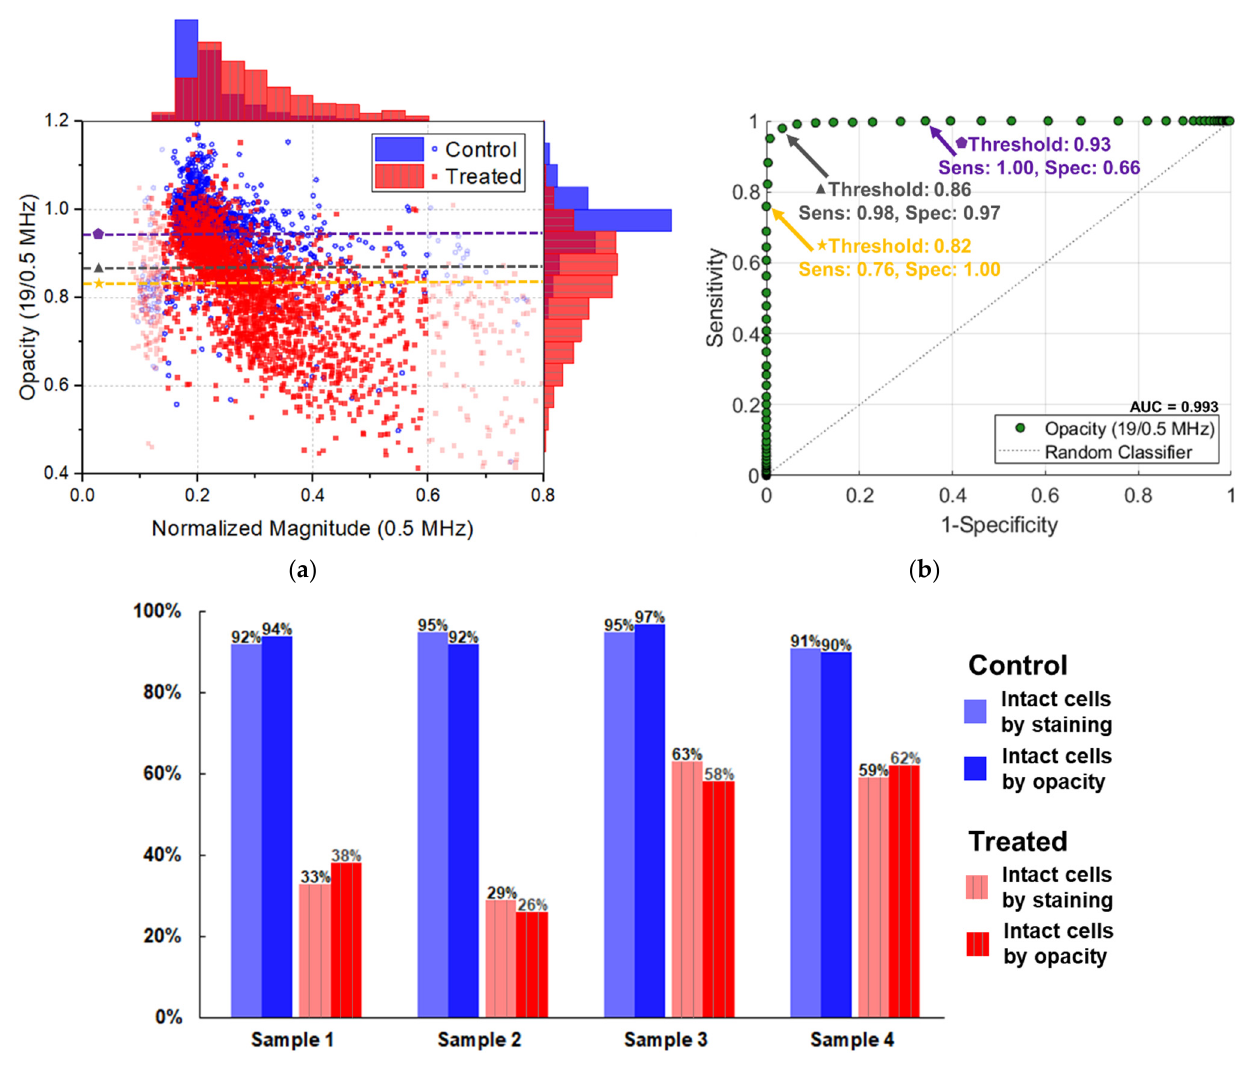
Figure 4. Moving the threshold to find the most specific and sensitive threshold that holds up for all samples. ( a ) Scatterplot with dotted lines representing the thresholds 0.93, 0.86 and 0.82. ( b ) ROC curve of all samples with thresholds between 0.4–1.2, with an area under the curve of 0.993. ( c ) Bar graph to compare of acrosome intact cells by staining and opacity of the control and treated sample at a threshold of 0.86.